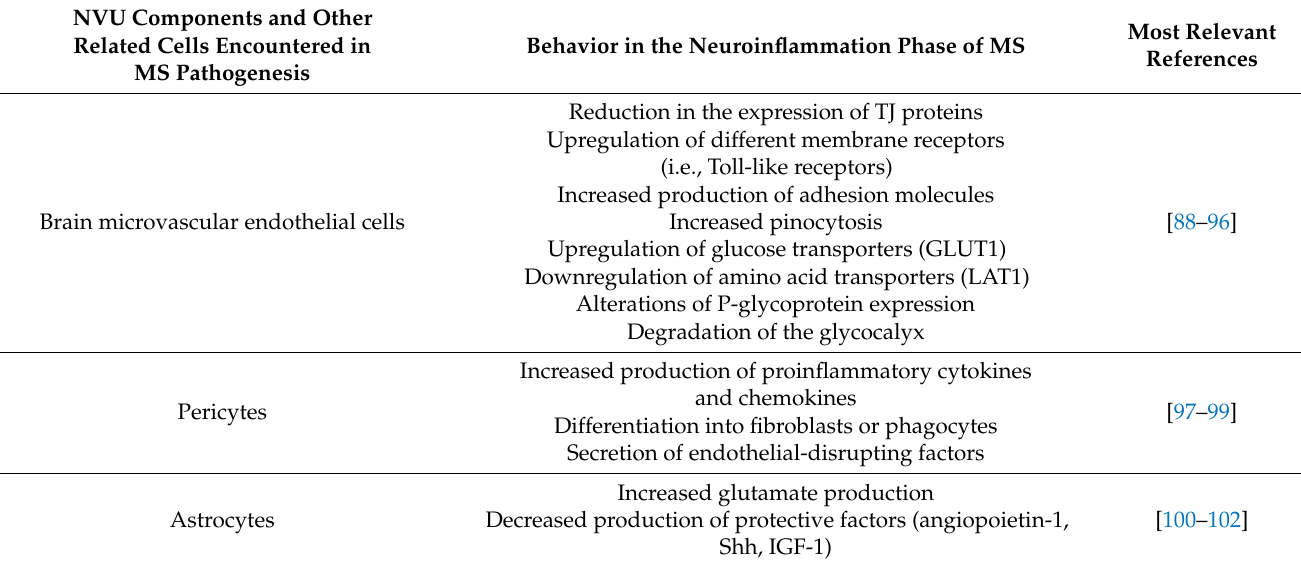
Table 2. Overview of alterations of the NVU components in the inflammatory state of multiple sclerosis. NVU Components and